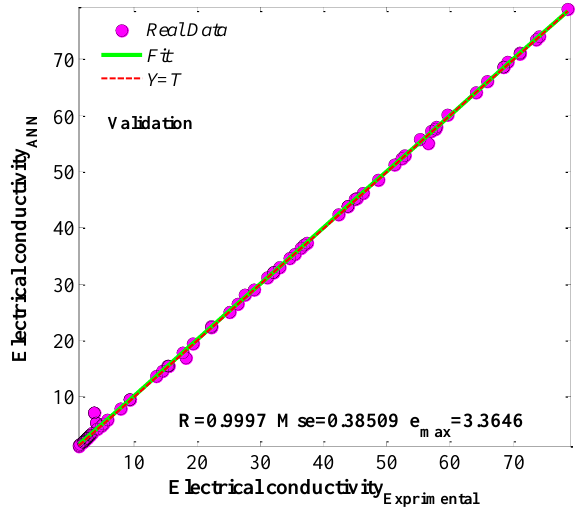
Figure 7. Comparison of predicted values of electrical conductivity of nanofluids by neural networks and experimental results for validation data .